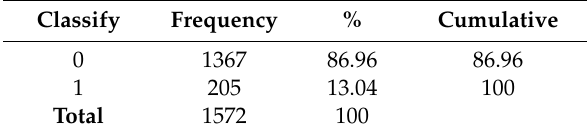
Table 2. Descriptive statistics of dependent variable post-GFC (2010–2017). Classify Frequency %